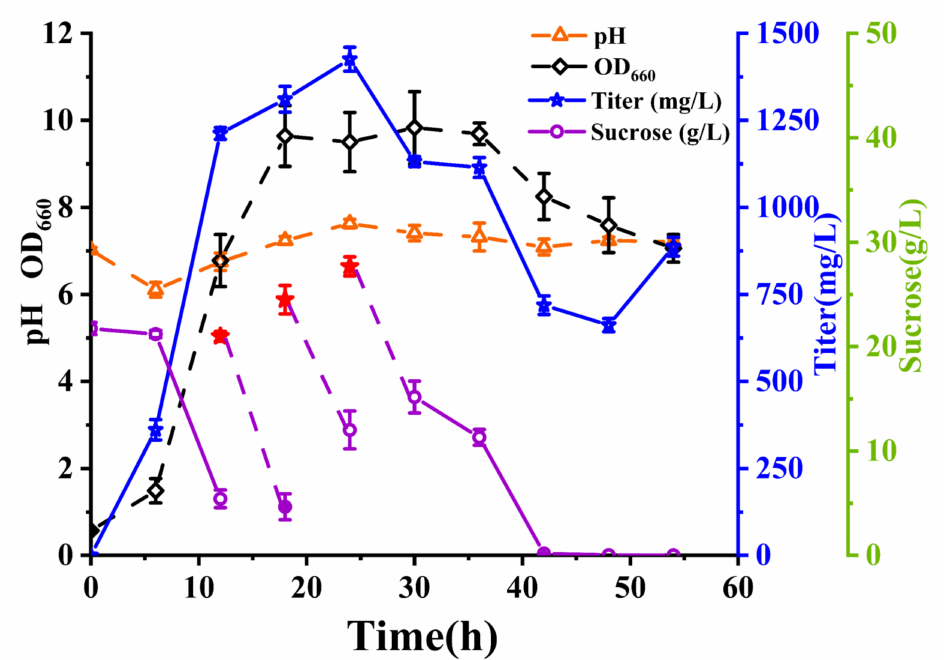
Figure 4. Growth kinetic curves for fed-batch fermentation production of